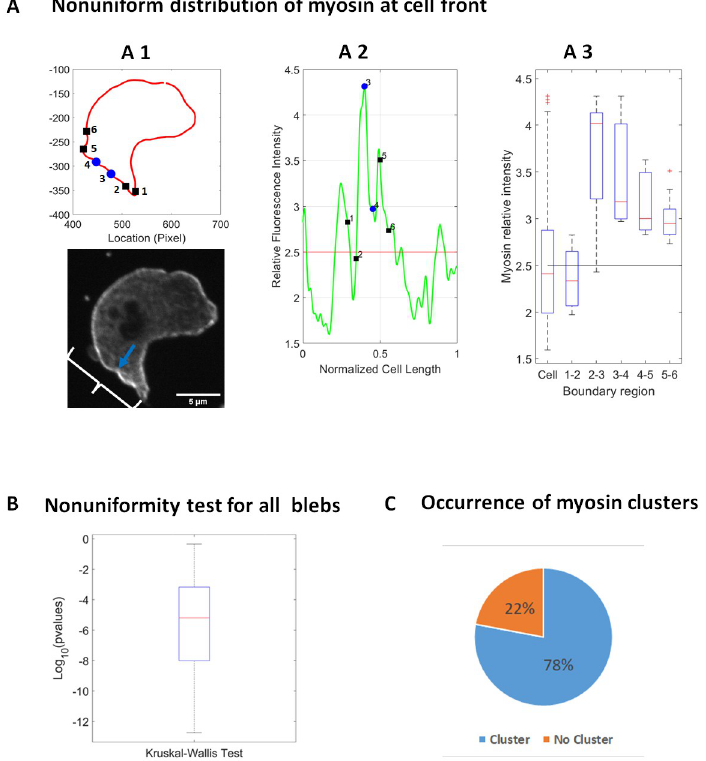
Fig 4. Microscopy evidence for non-uniform distribution and anterior clustering of myosin II at the cell front prior to bleb initiation. A1) (Top) The boundary of the cell (in red) showing the bleb shoulder points enclosing the bleb neck (blue dots) and the neighboring regions (black squares). (Bottom) Microscopy image shows a Dictyoselium discoideum cell expressing myosin-GFP prior to the formation of a bleb. The front of the cell just before the emergence of a bleb is marked with the curly bracket and the location of the incoming bleb by the blue arrow. A2) Smoothed myosin fluorescence intensity (relative to the cytoplasmic intensity) around the cell boundary showing the bleb shoulder points (blue dots) and neighboring boundary regions (black squares). The mean whole cell myosin intensity is marked by the red line. A3) A box plot showing the distribution of myosin intensity around the cell and in the neighboring regions of the bleb. Mean intensity is marked by black line. B) Distribution of p-values from Kruskal- Wallis tests of nonuniformity in the myosin intensity within regions at the front of the cell. C) A pie chart showing the percentage of blebs that formed with at least one myosin cluster in their surrounding region (Chi-square test, pvalue =